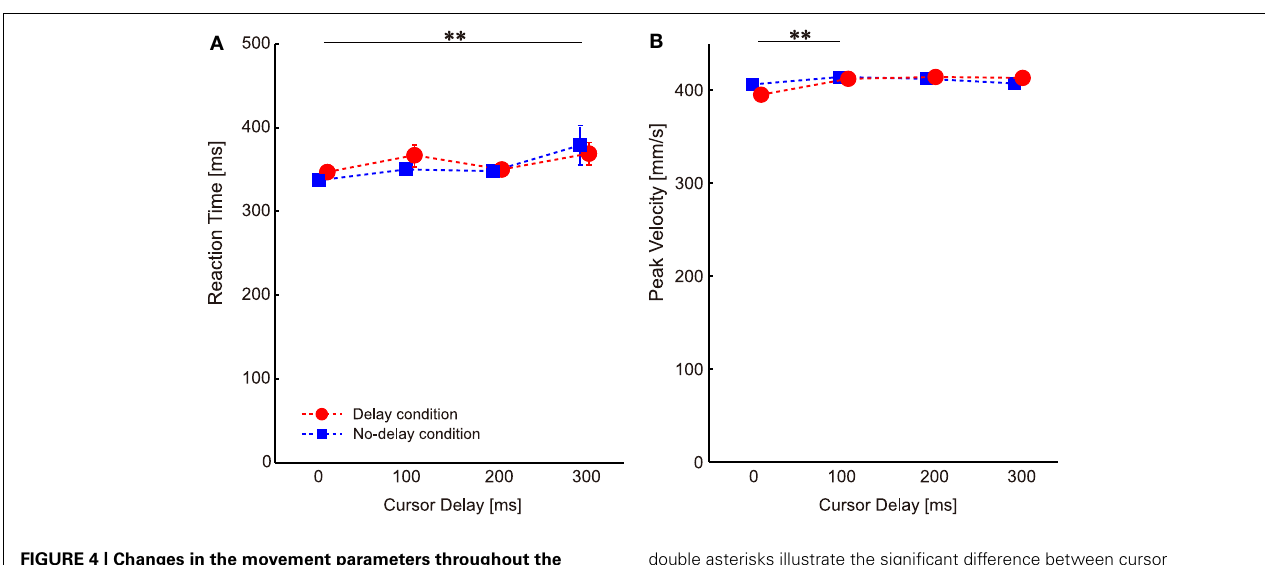
FIGURE 4 | Changes in the movement parameters throughout the experiments. (A) Reaction time. (B) Peak velocity. Data are sorted according to the cursor delay in the previous perturbation trials.The